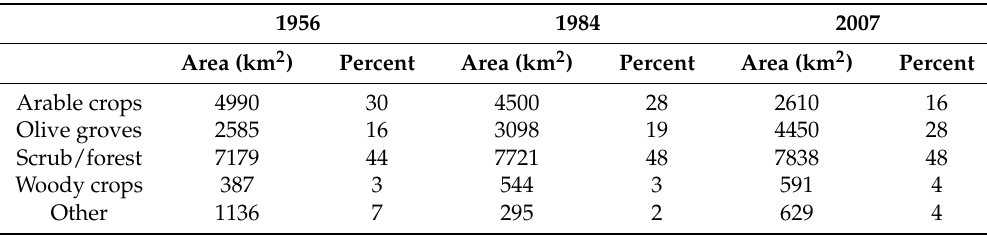
Table 6. Evolution of soil use in the Guadalquivir basin draining the study area between the years 1956, 1984 and